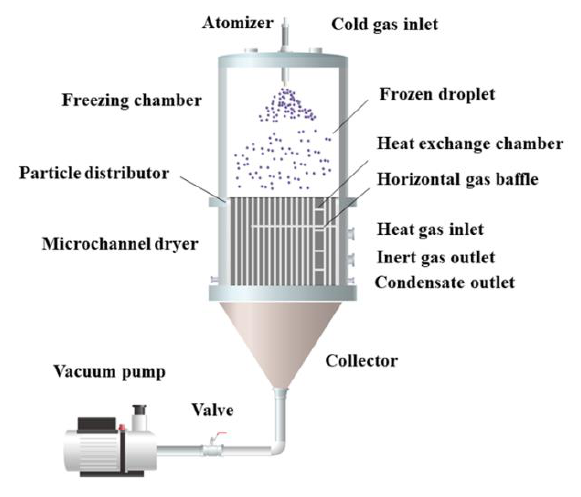
Figure 4. Flow chart of spray freezing microchannel drying